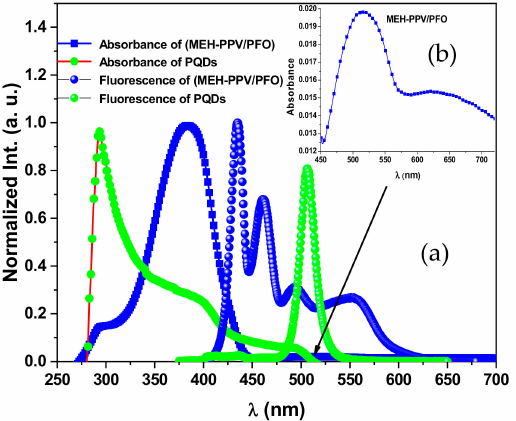
Figure 11. PL and absorption normalized spectra of the MEH–PPV/PFO hybrid and CsPbBr 3 -PQDs thin films as a function of wavelength ( a ). The inset is the absorbance of MEH-PPV/PFO in the range 450–700 nm ( b